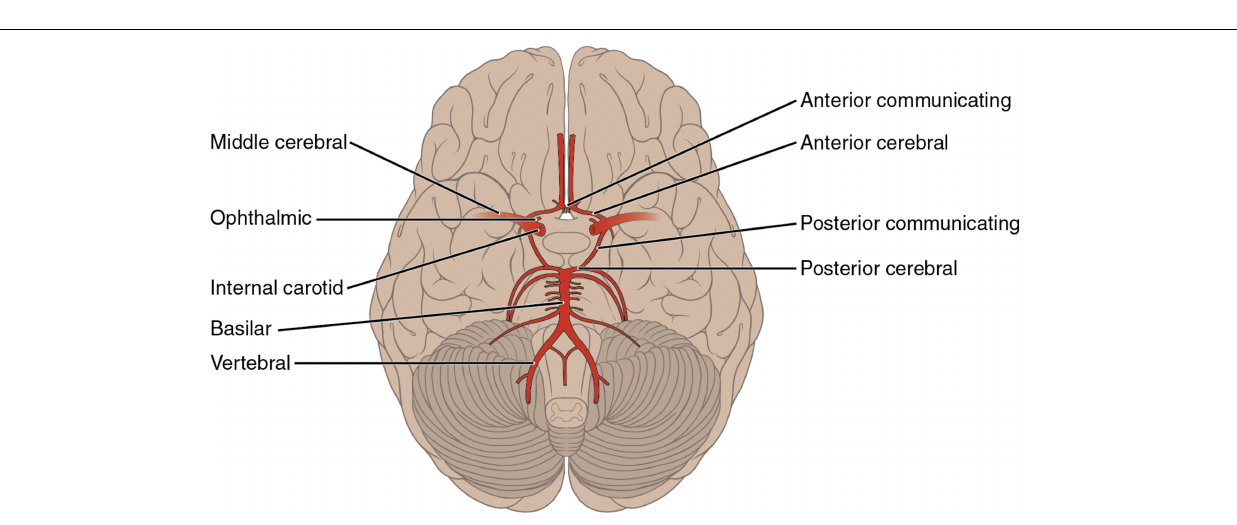
FIGURE 1 | Territory irrigated by the Anterior Cerebral Artery (ACA). The ACA irrigates the medial surface of the brain and the upper border of the frontal and parietal lobes.